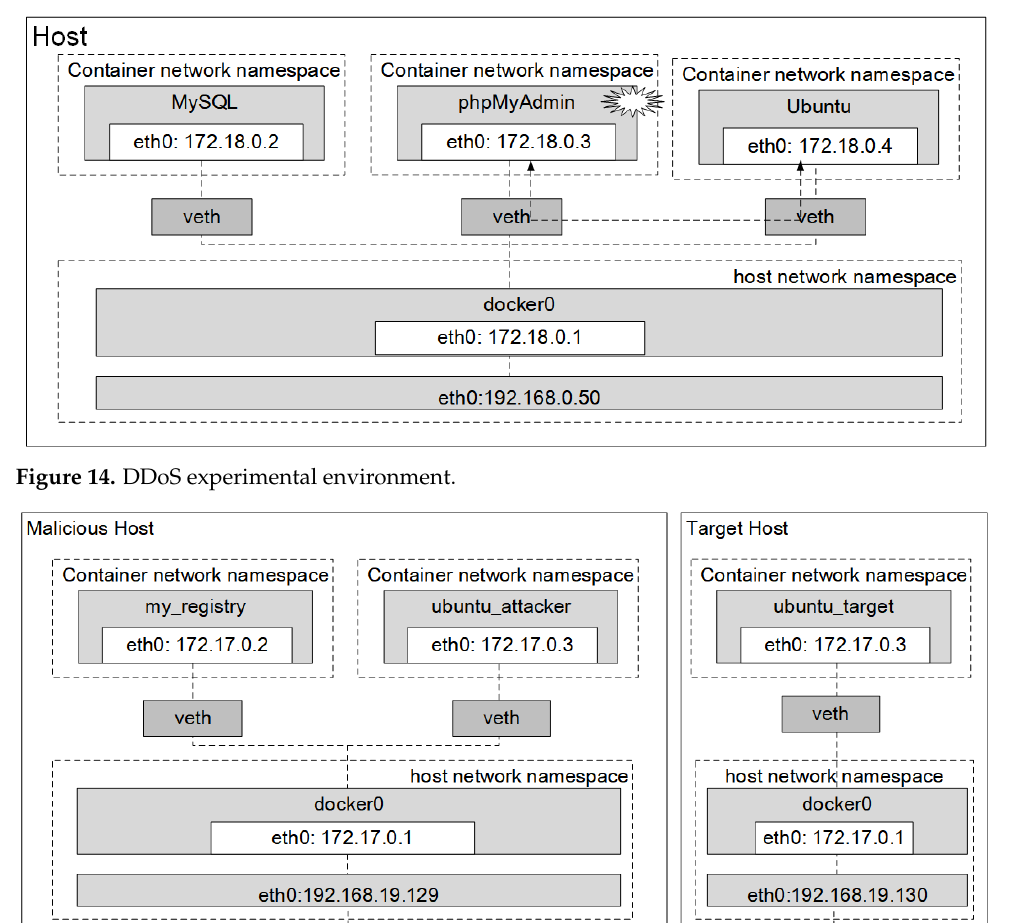
Figure 13. Experimental environment for the ARP spoofing.